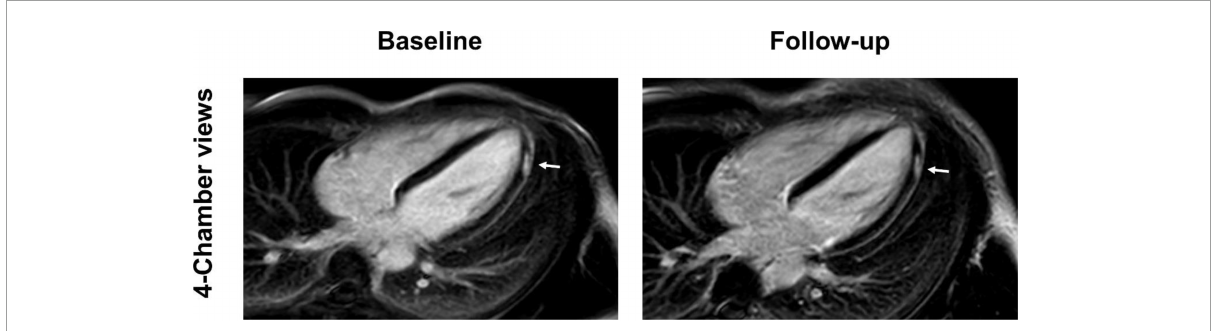
FIGURE5 4-chamber late gadolinium enhancement (LGE) views of a 36-year-old, previously healthy male after receiving the third dose of the Pfizer/BioNTech vaccine. The LGE lesion at the apical lateral wall (arrow) reduced at follow-up 3 months later, but was still visible, a finding which is consistent with scar tissue. Patient reported complete resolution of clinical symptoms which included chest pain and palpitations.